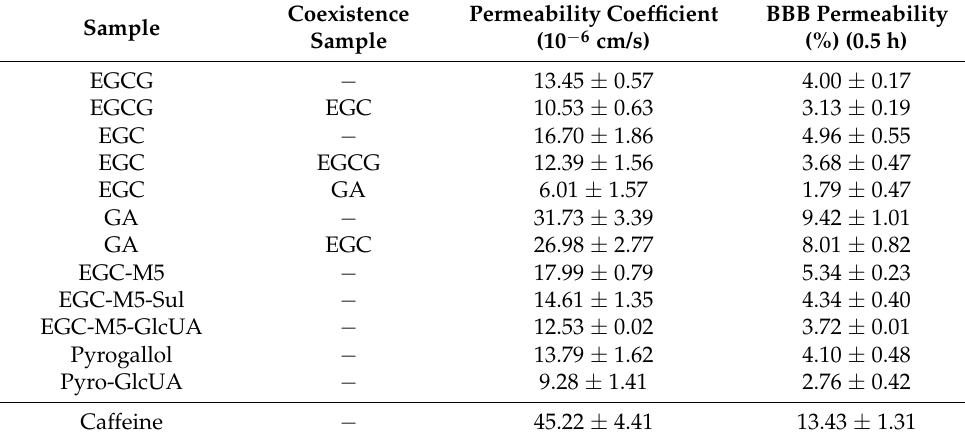
Table 1. BBB permeability of green tea catechins and their metabolites.